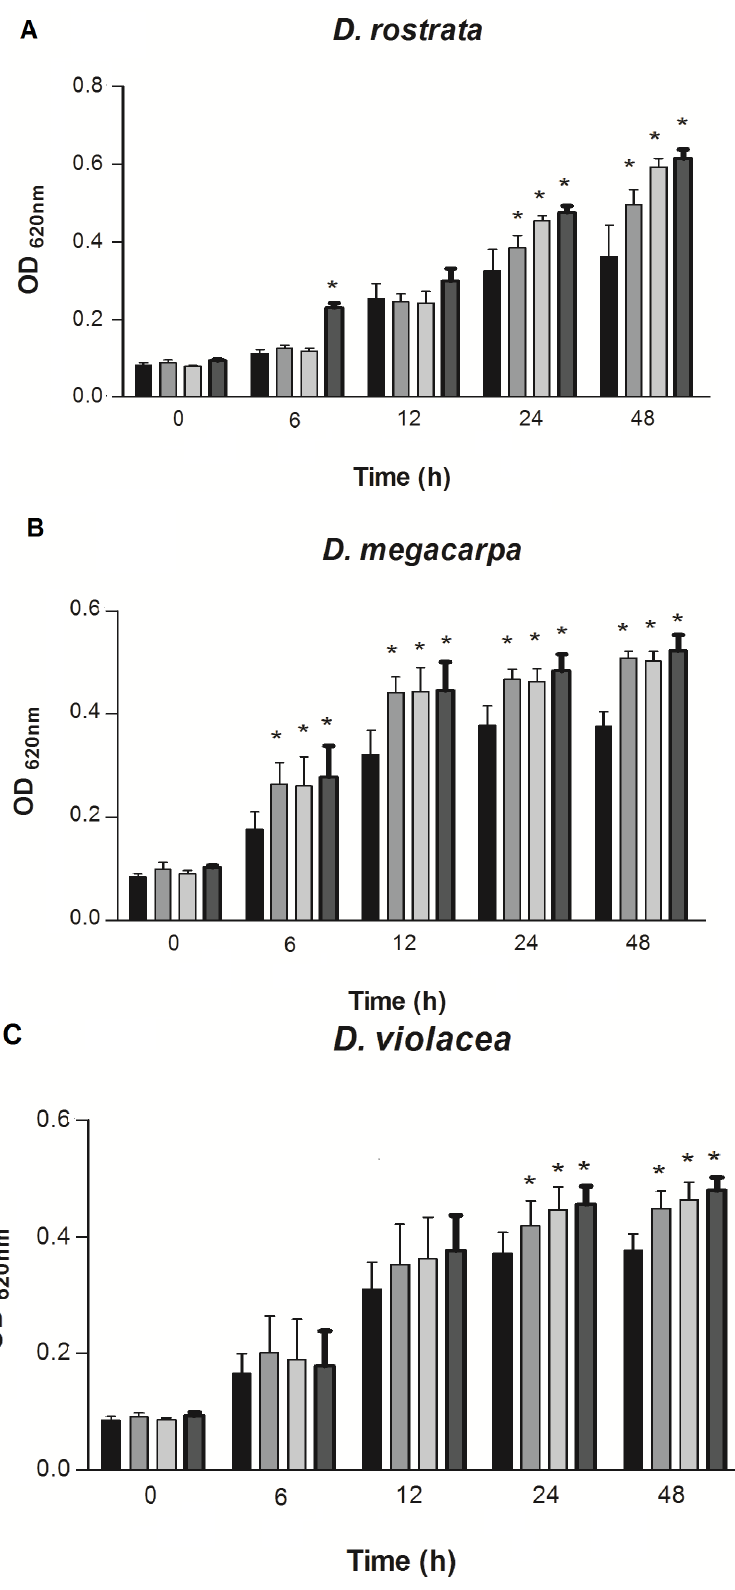
Figure 2. Effect of D -glucose/ D -mannose-specific lectins on the growth of R. tropici . ( A ) DRL, ( B ) DML and ( C ) DVL. * p < 0.01 relative to control. Error bars indicate the standard deviation of the means. ( ) Control, ( ) lectins at 125 µg/mL, ( ) 250 µg/mL and ( ) 500